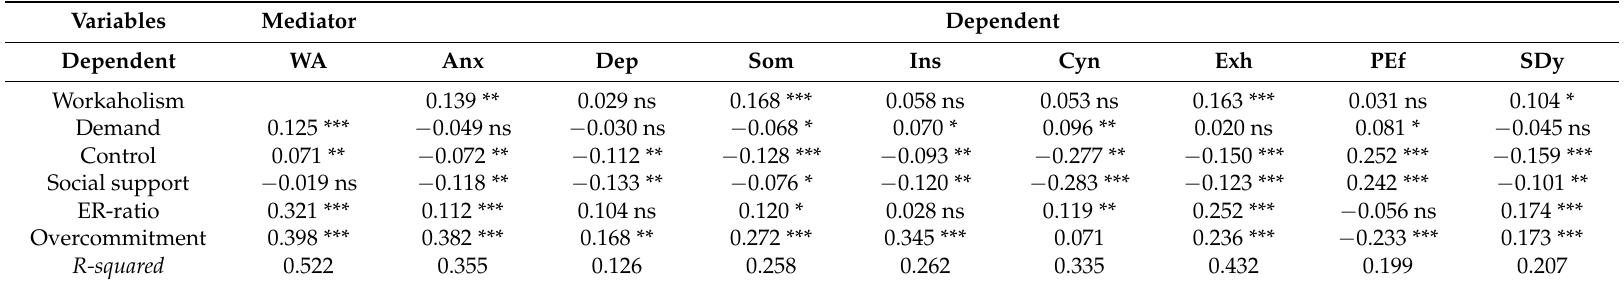
Table 3. Standardized coefficients from the mediation path